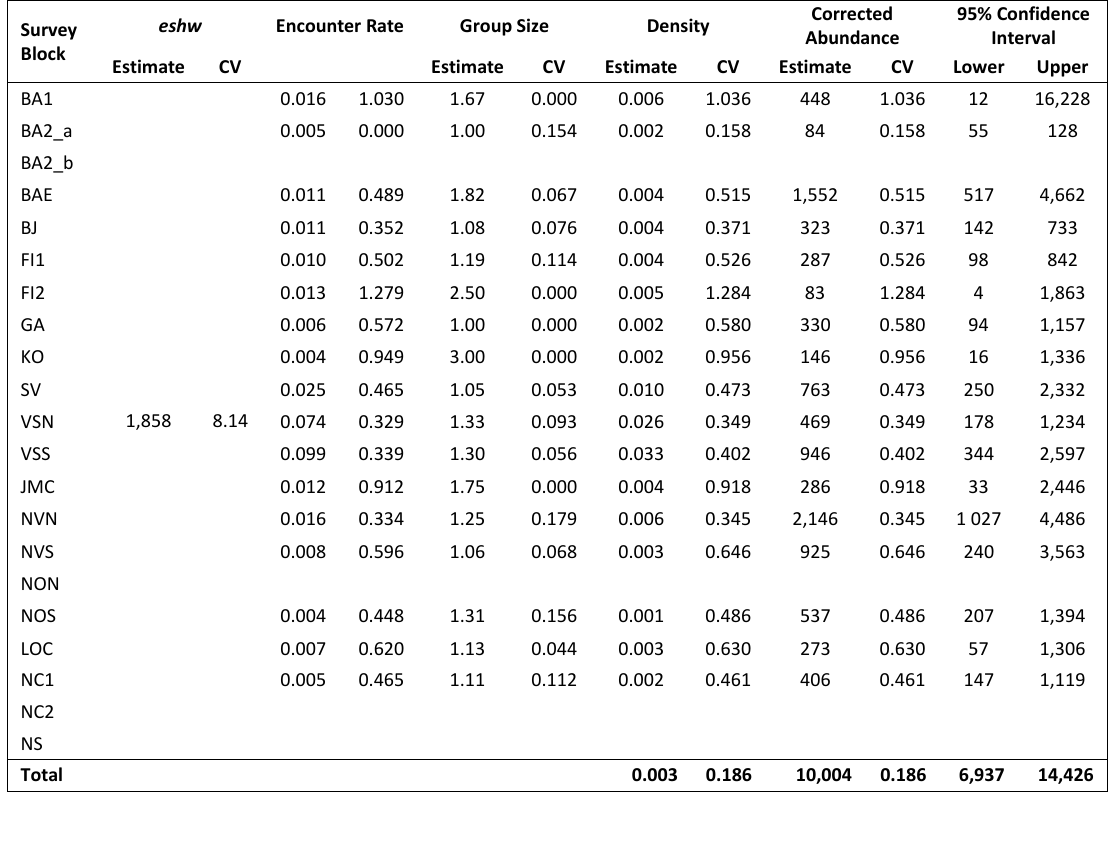
Table 6. Estimated density and abundance of fin whales from the 2002 – 2007 survey (a) and the 2008 – 2013 survey (b). The eshw (effective search half width (m)) was estimated for the entire study area. Encounter rate, group size, density, abundance, and upper and lower confidence limits were estimated by block and corrected for perception bias, with the estimated p